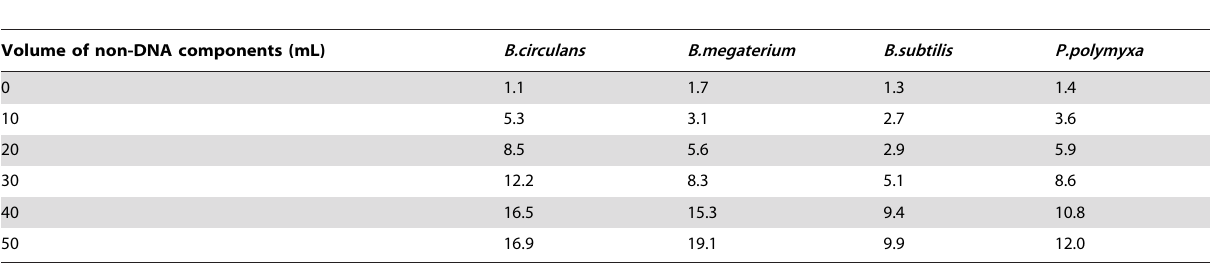
Table 1. Organism dependent Selectivity Index values during reconstitution of selective flotation tests using fixed amount (2 mg) of